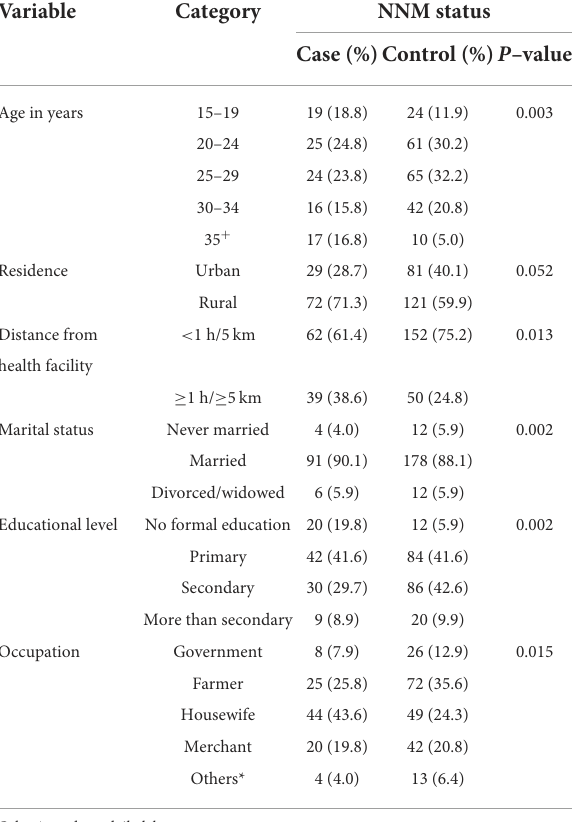
TABLE 3 Obstetrics characteristics of mothers among neonates admitted ( n = 303) to public hospitals of Ilu Abba Bor Zone, 2020. Variables Category Near miss